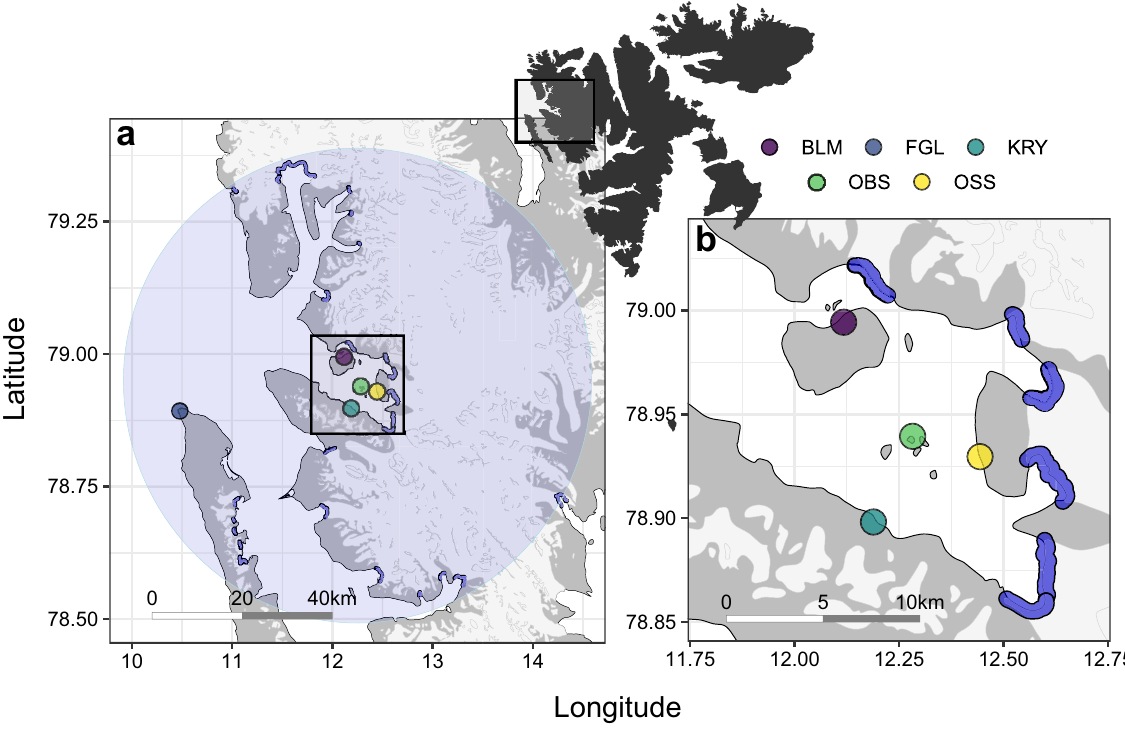
Figure 1. Svalbard archipelago (top; land in black), ( a ) the 50 km radius area corresponding to the regional scale, and ( b ) the Kongsfjorden area corresponding to the fjord scale. Kittiwake breeding colonies (circles: BLM (purple) = Blomstrand; FGL (dark blue) = Fuglehuken; KRY (cyan) = Krykkjefjellet; OBS (green) = Observasjonsholmen; OSS (yellow) = Ossian Sarsfjellet) and glacier fronts (blue areas) are also shown. Maps were generated using R (version 4.0.2 42 ; URL: https:// www.R- proje ct.